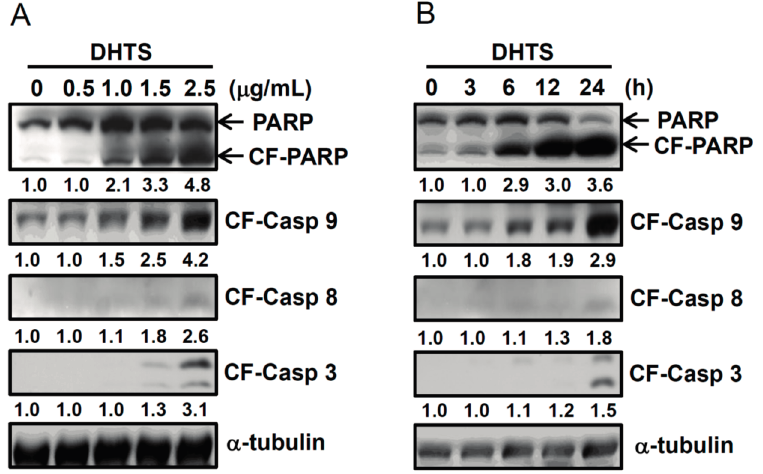
Figure 2. Effects of 15,16-dihydrotanshinone I (DHTS) on activation of caspases in human HL-60 promyelocytic leukemia cells. Cells were treated with ( A ) various concentrations of DHTS for 24 h or ( B ) 1.5 μ g/mL DHTS for different time periods, and total cellular proteins were collected to determine protein expressions by Western blotting. CF, cleaved